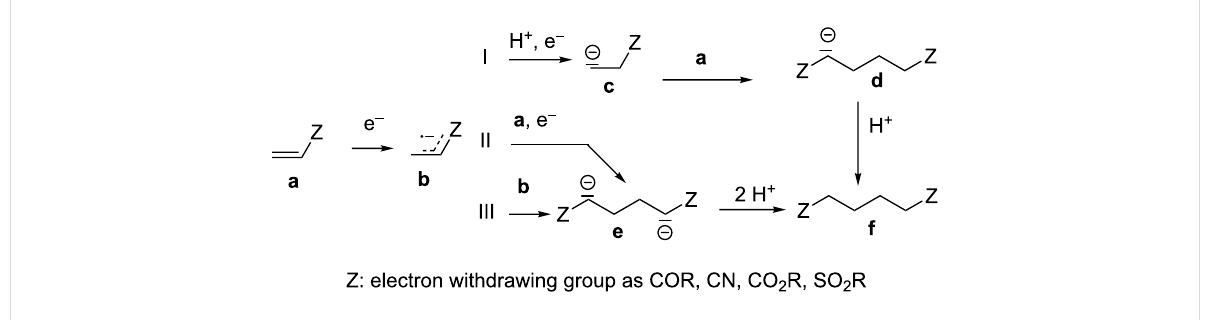
Scheme 1: Proposed mechanisms via pathways (I) to (III) for the cathodic hydrodimerization of olefins with electron attracting substituents.